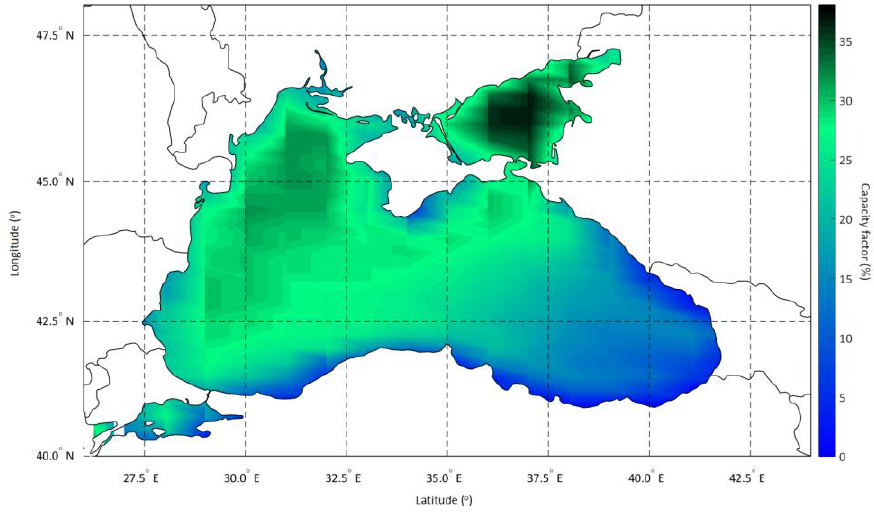
Figure 11. Airborne 5 MW — capacity factor (in %) expected for the U200 wind conditions.